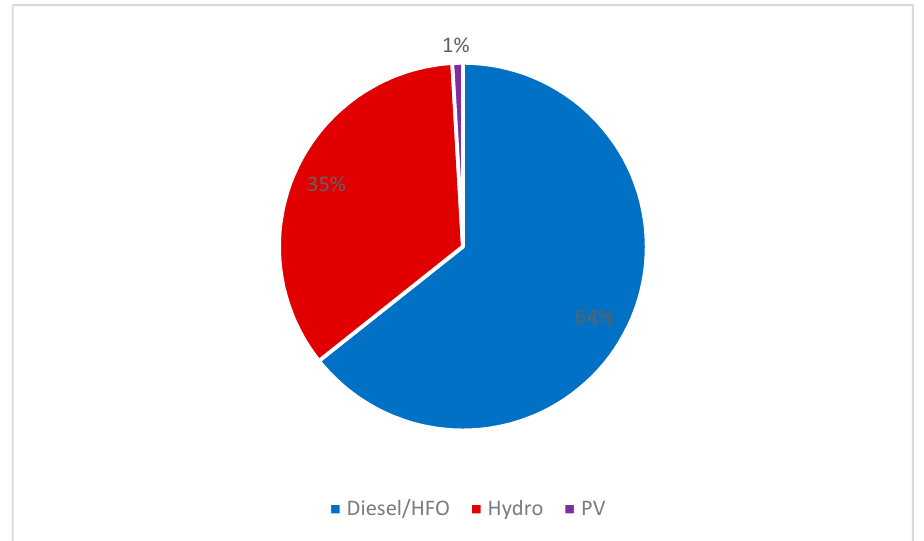
Figure 2. Share of RE and Diesel/HFO regarding power generation. Data source: N.V. EBS (2016) [7].